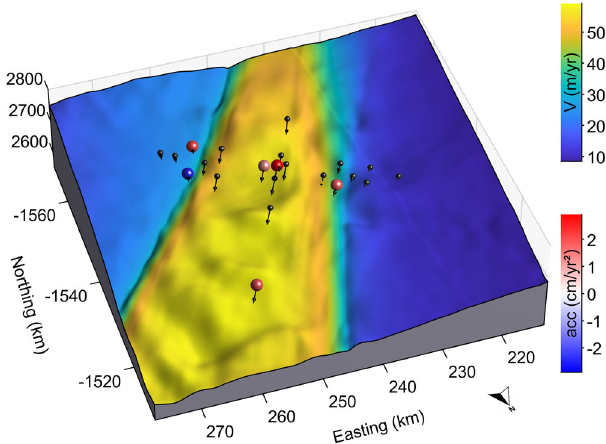
Fig. 2 | GPS observations of stakes at EastGRIP show accelerating ice fl ow. Backgroundmapshowsicevelocities 29 drapedoverthelandscape.Arrowsindicate the velocity and fl ow direction of each stake. Sphere colors show the estimated acceleration at each stake where it exceeds 1 σ (uncertainties shown in online methods Fig.